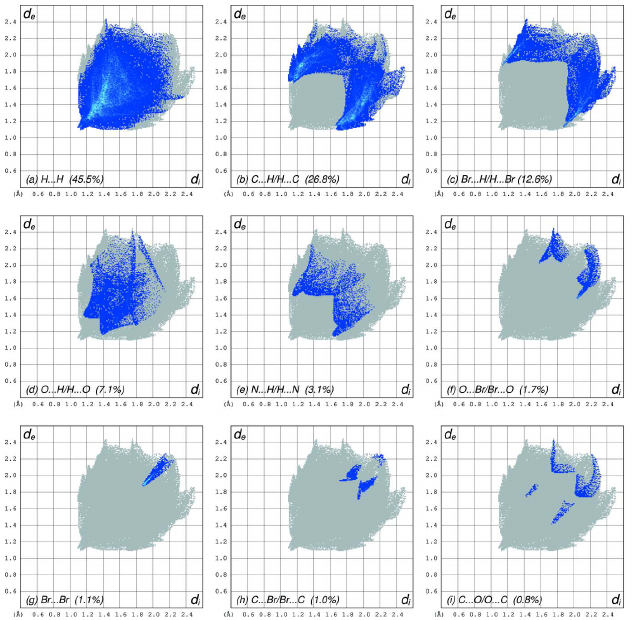
Figure 6 Hirshfeld surface analysis fingerprint plots showing the relative coverage of different atom-atom contacts in II : ( a ) H (cid:2)(cid:2)(cid:2) H = 45.5%, ( b ) C (cid:2)(cid:2)(cid:2) H/ H (cid:2)(cid:2)(cid:2) C = 26.8, ( c ) Br (cid:2)(cid:2)(cid:2) H/H (cid:2)(cid:2)(cid:2) Br = 12.6%, ( d ) O (cid:2)(cid:2)(cid:2) H/H (cid:2)(cid:2)(cid:2) O = 7.1%, ( e ) N (cid:2)(cid:2)(cid:2) H/H. (cid:2) N = 3.1%, ( f ) O (cid:2)(cid:2)(cid:2) Br/Br (cid:2)(cid:2)(cid:2) O = 1.7%, ( g ) Br (cid:2)(cid:2)(cid:2) Br = 1.1%, ( h ) C (cid:2)(cid:2)(cid:2) Br/Br (cid:2)(cid:2)(cid:2) C = 1.0%, (i) C (cid:2)(cid:2)(cid:2) O/O (cid:2)(cid:2)(cid:2) C = 0.8%. All other contacts are